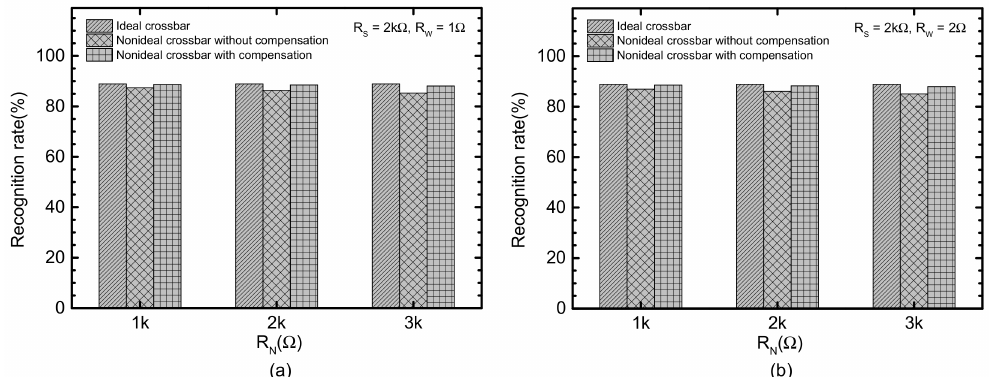
Figure 9. ( a ) Comparison of the recognition rate of the nonideal crossbars between without and with the correction circuit for CIFAR-10 data set with R W = 1 Ω ( b ) Comparison of the recognition rate of the nonideal crossbars between without and with the correction circuit for CIFAR-10 data set with R W = 2 Ω